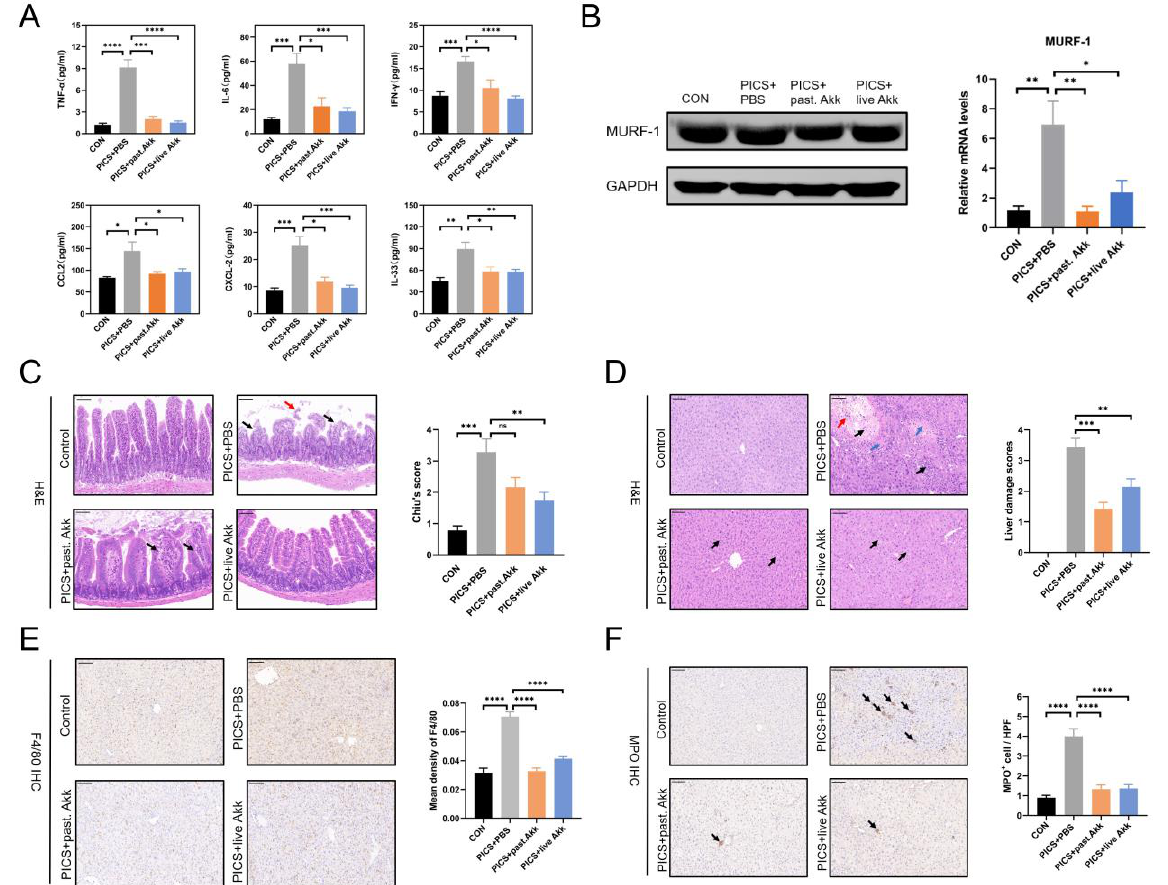
Figure 2. Akk exhibited systemic, hepatic and intestinal anti-inflammatory effects and alleviated hypercatabolism in PICS mice. ( A ) Levels of serum inflammatory indices including TNF- α , IL-6, IFN- γ , CCL2, CXCL2 and a novel biomarker in immunosuppression induction, IL-33, in the four groups. ( B ) The protein (left) and mRNA levels (right) of MuRF-1 were detected by immunoblotting and qRCR. ( C ) Representative H&E staining of ileum tissue. Black arrows indicate separation of intestinal epithelial cells from the lamina propria. The red arrow indicates shedding of intestinal epithelial cells at the villi tip. ( D ) Representative H&E staining of liver tissue. Blue arrows indicate focal necrosis. Black arrows indicate inflammatory cell infiltration. The red arrow indicates hemorrhage. ( E , F ) Representative images and quantification of IHC staining of F4/80 ( E ) and MPO ( F ) in liver tissue (indicated by black arrows). Black arrows indicate inflammatory cell infiltration. Scale bars, 100 µm. ns = not significant; Past. = pasteurized. Data are shown as the mean ± SEM ( n = 5 mice per group). * p < 0.05, ** p < 0.01, *** p < 0.001, **** p < 0.0001.